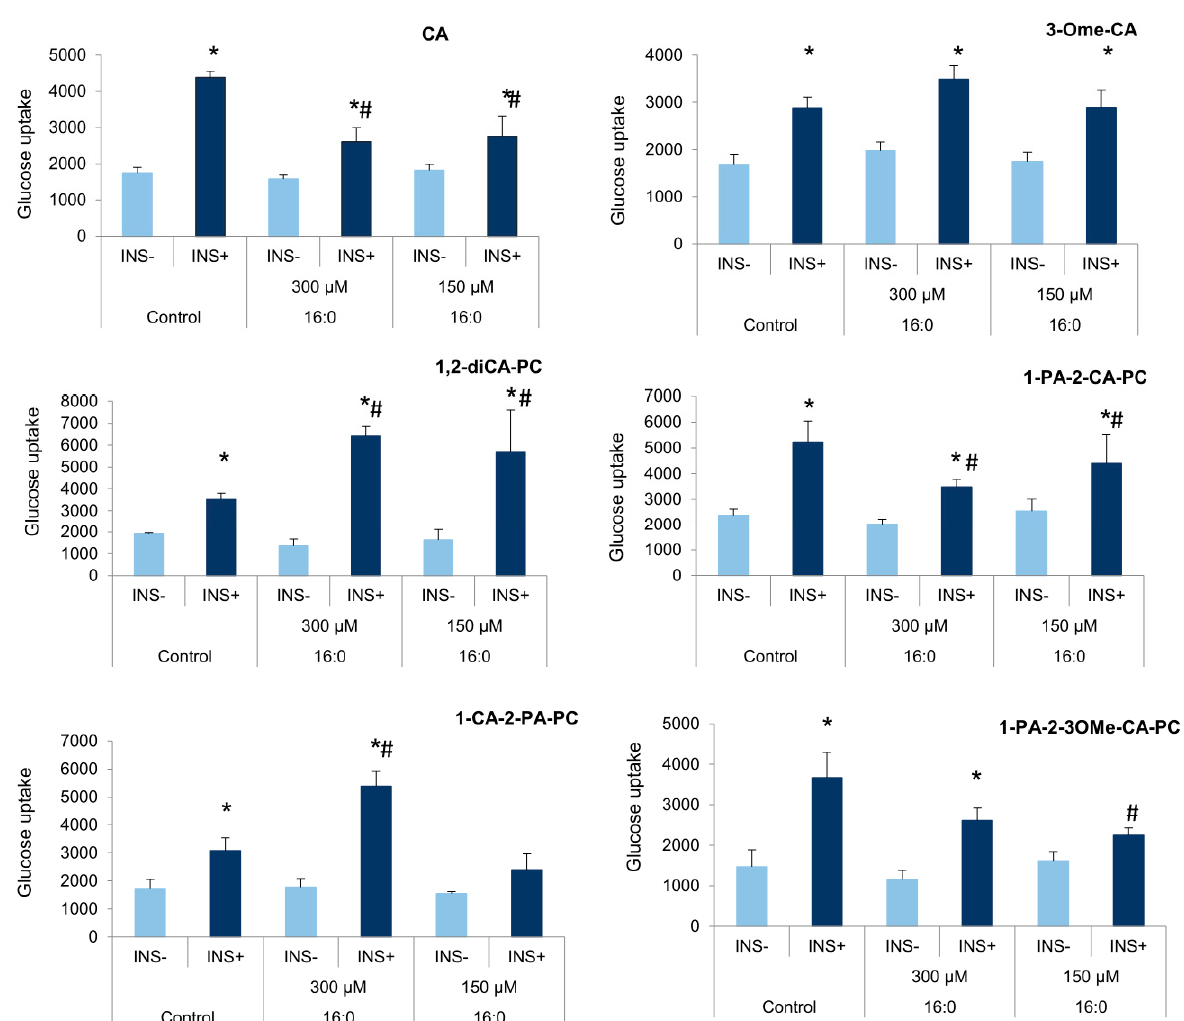
Figure 6. The insulin-stimulated glucose uptake after insulin resistance induction in 3T3-L1 adipocytes cultured with cinnamic acid, 3-methoxycinnamic acid, and its derivatives; * statistical significance in relation to basal glucose uptake measured separately for each compound (INS − ); # statistical significance between insulin-stimulated glucose uptake (INS+) in experimental and control cells; Student’s t -test, p < 0.05.